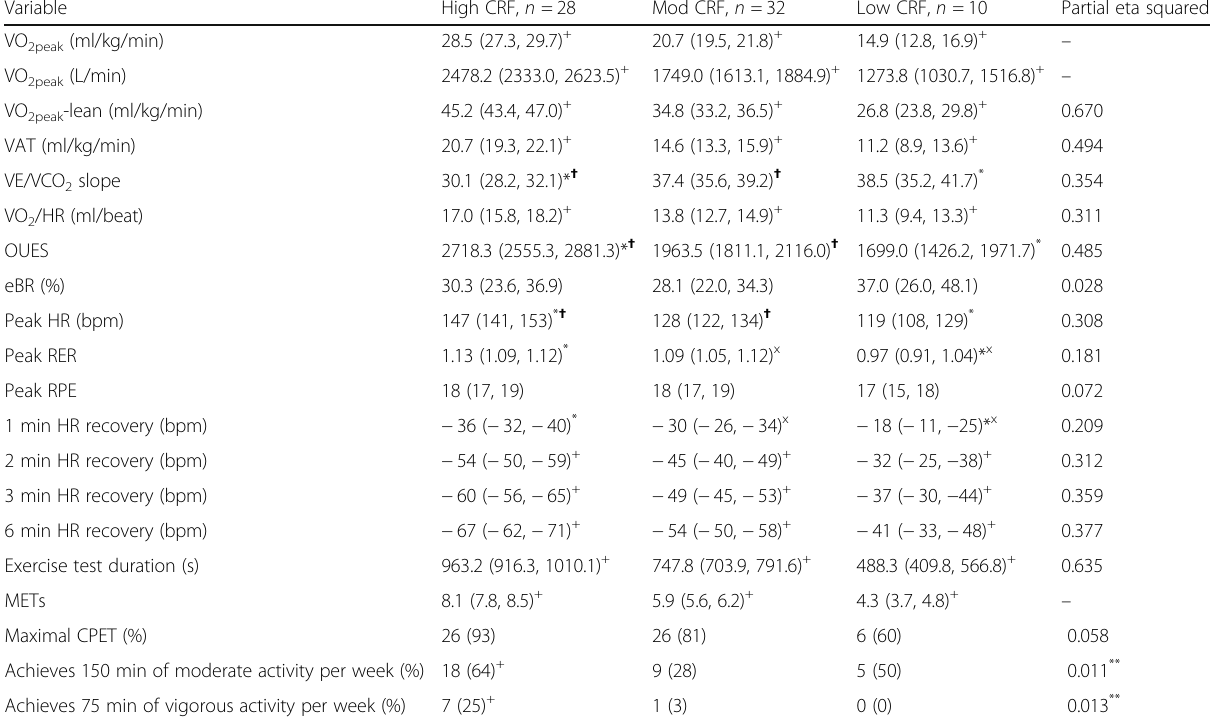
Table 4 Cardiorespiratory Fitness and Physical Activity Characteristics Expressed as Mean (95% Confidence Intervals) Variable